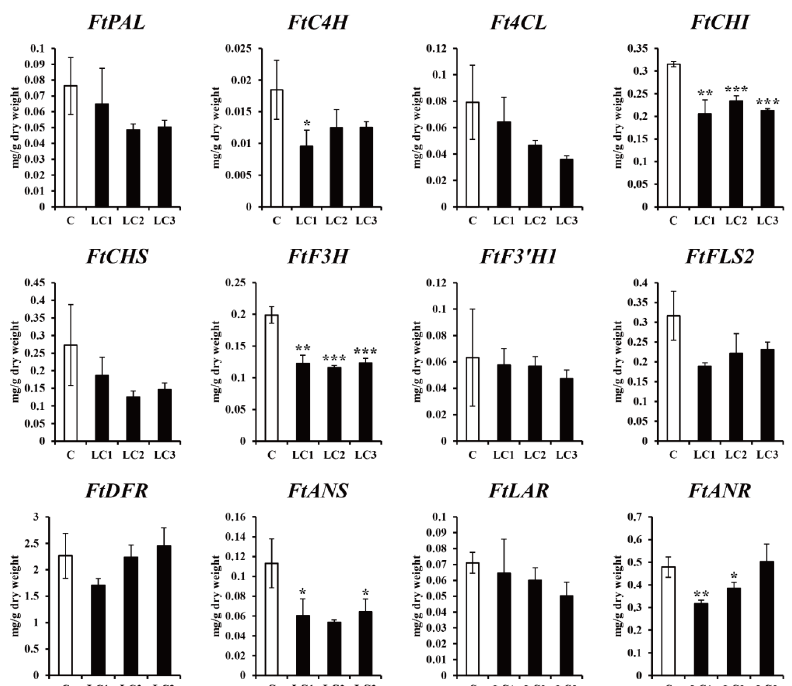
Figure 3. Effect of dark treatment on the expression profiles of hairy root cultures in Fagopyrum tataricum . C: GUS -overexpressing hairy root line 1; LCn: ZmLC -overexpressing hairy root lines. Asterisks represent statistical significance (* p < 0.05; ** p < 0.01; *** p < 0.001).